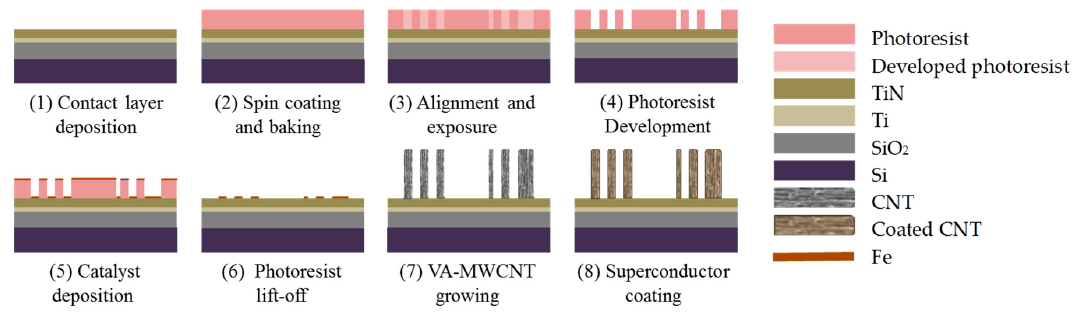
Figure 1. Schematic of microfabrication process; (1) SiO2 deposited and Ti/TiN (10/50 nm) sputtered on a silicon wafer as a barrier layer, (2) photoresist (1.4 µm) coated and baked, (3) wafer aligned and